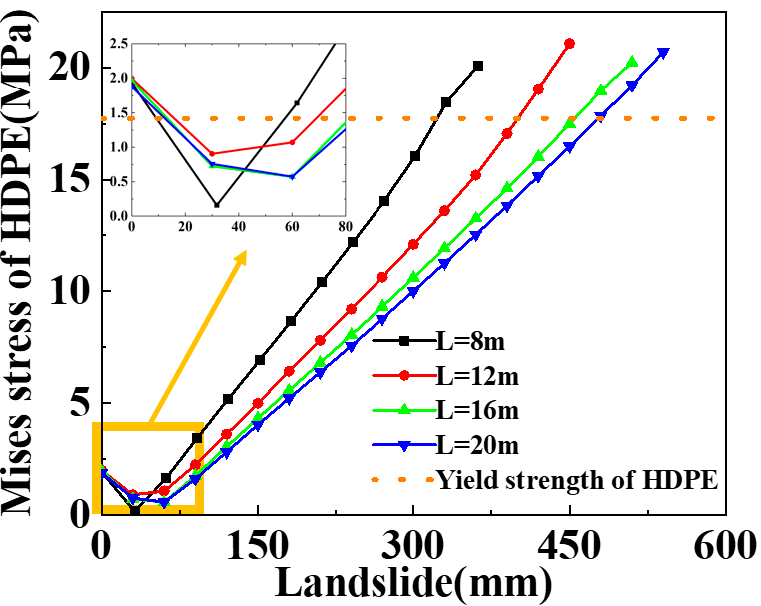
Figure 16. Influence of landslide on the maximum Mises stress of point B with different landslide area widths.